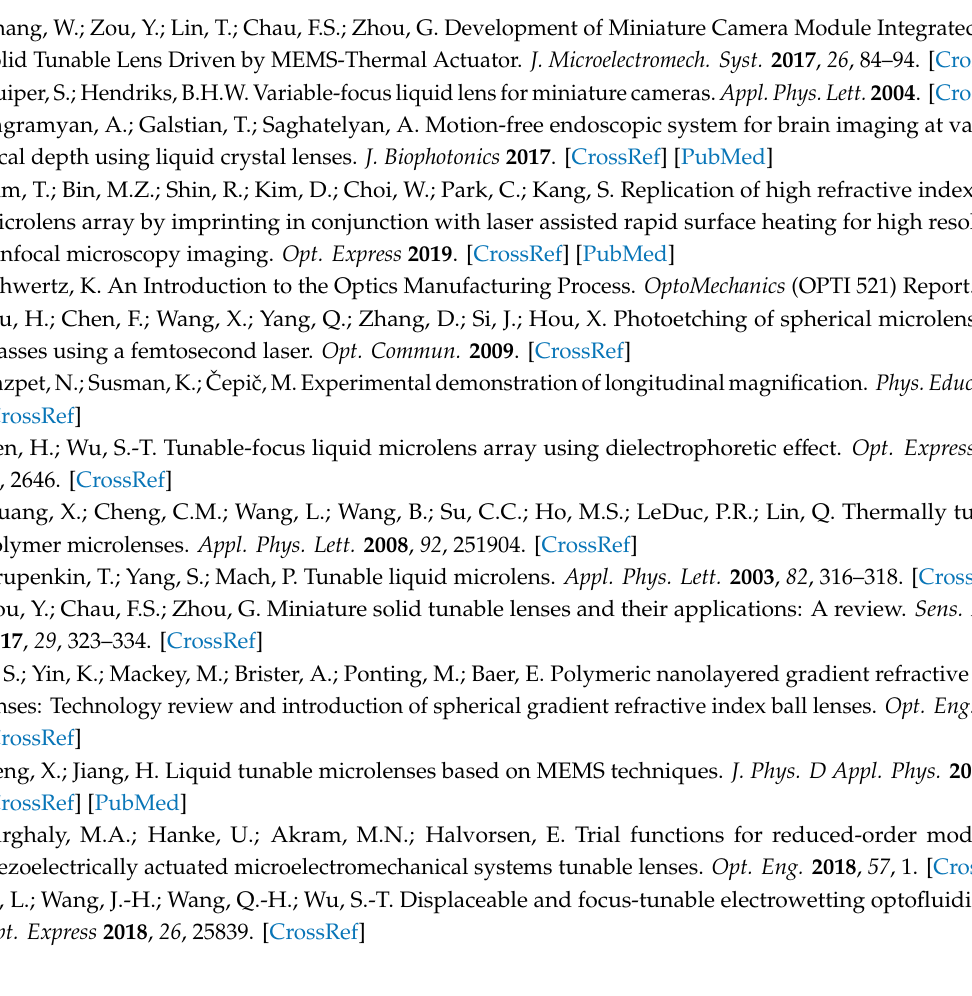
Figure S1: Magnification comparison under di ff erent diameters of microlenses. ( a ) The original size of 90 µ m fluorescent microbeads. ( b ) The same microbeads viewed via 400 µ m thin glass microlens and 1.45 of magnification achieved. ( c ) The microbeads put under 700 µ m microlens and produced 1.64 magnification. ( e ) and ( d ) are the comparison images of observing a letter using a 1 mm diameter of the microlens. Unmark scale bar is 500 µ m, Figure S2: Illustration of microlens connected with or without microchannel. ( a ) Image of the microlens arrays connected with microchannels. ( b ) The single (hollow) microlens without microchannel, Figure S3: The measuring results of di ff erent diameters of microlens with di ff erent magnifications at di ff erent positions. ( a ) This row of images are the 300 µ m microlens produced magnification at di ff erent positions. ( b ) The 500 µ m microlens produced magnification at di ff erent positions. ( c ) The 800 µ m microlens produced magnification at di ff erent positions. ( d ) The 1 mm microlens produced magnification at di ff erent positions. Unmarked scale bar is 300 µ m, Figure S4: The experiment of Nanobeads observation using thin glass microlens. From ( a–c ) are the 750 nm Nanobeads microscopic images under the di ff erent objective lens at various magnifications without microlens. ( d )